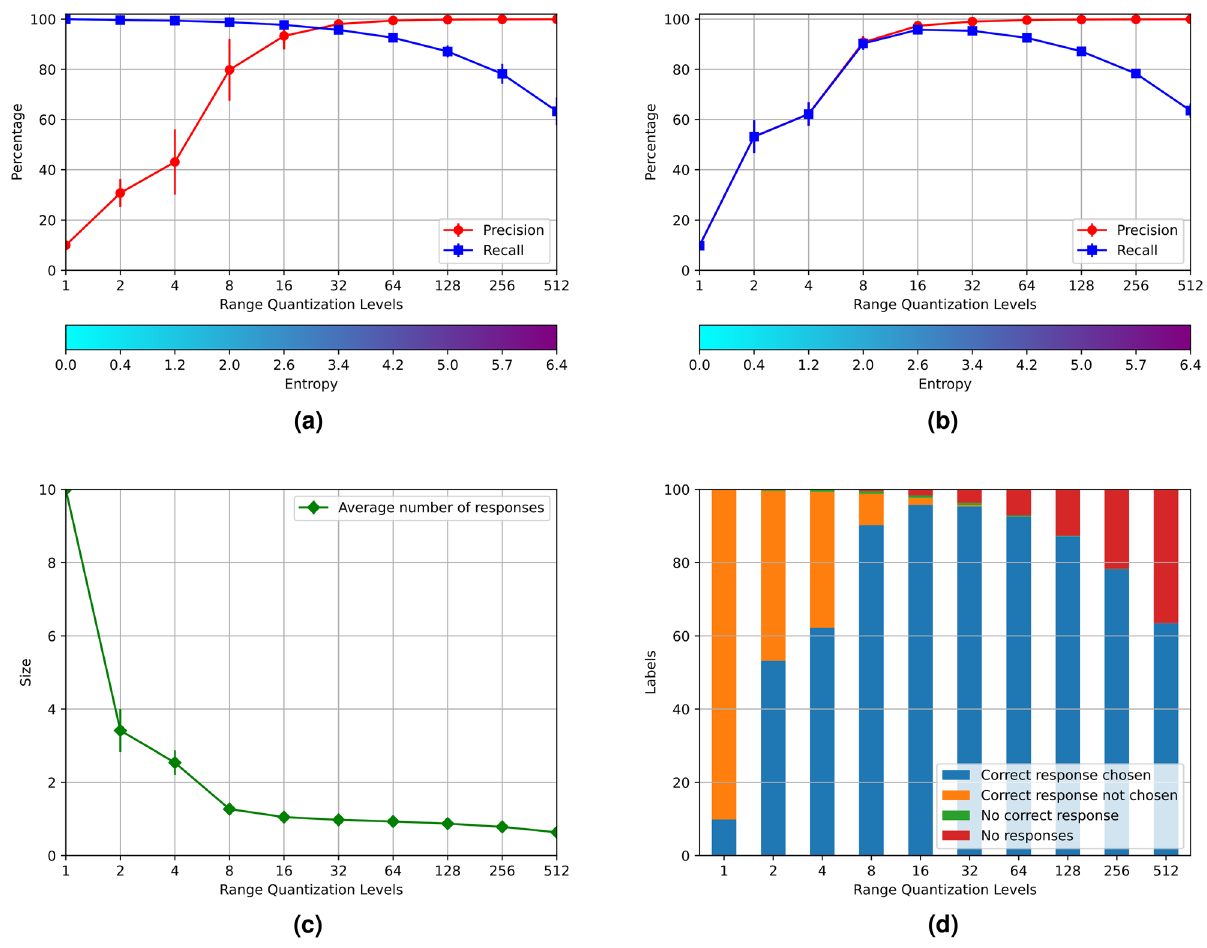
Figure 3. Results of experiment